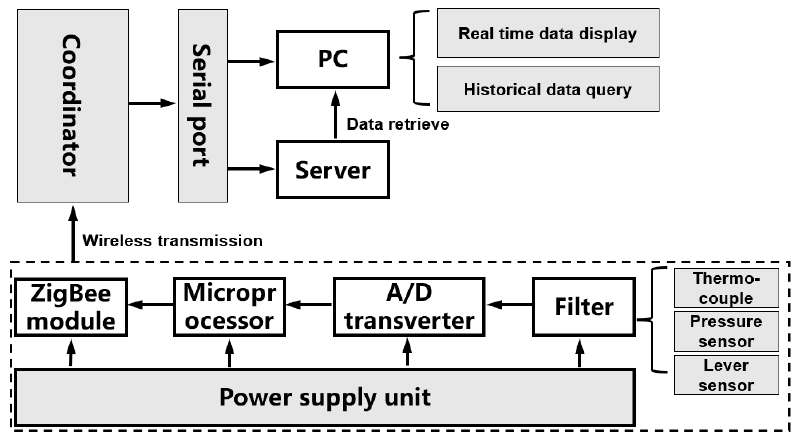
Figure 12. Structure and function diagram of the device parameter monitoring system.